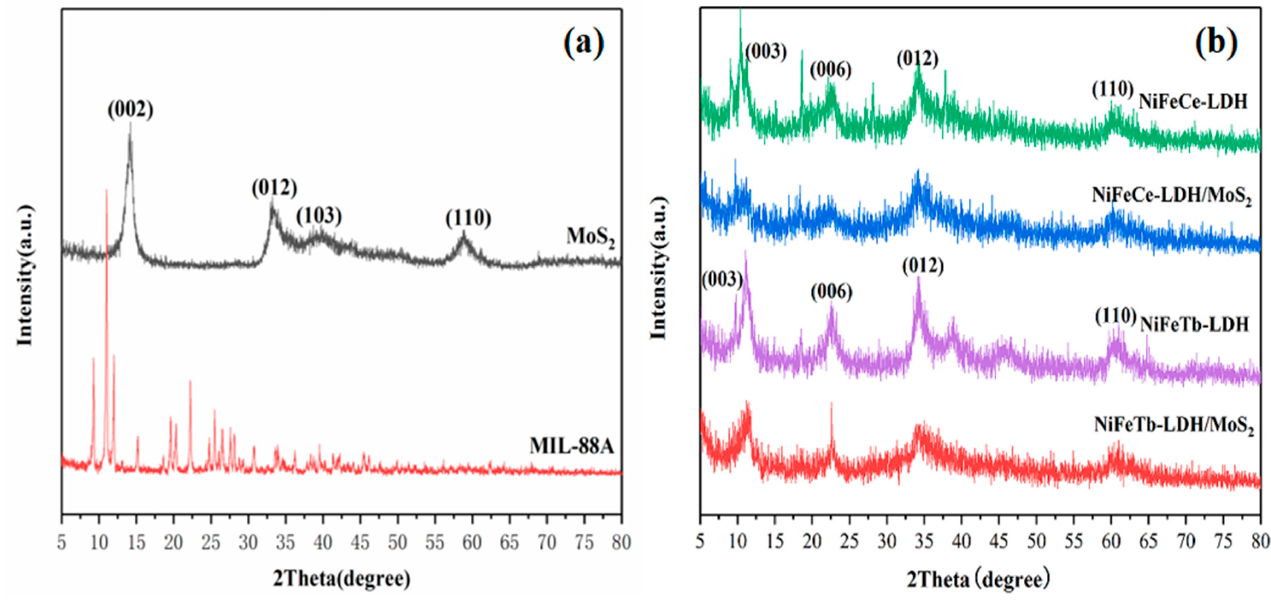
Figure 2. XRD patterns of MIL-88A, MoS 2 ( a ) and NiFeCe-LDH, NiFeTb-LDH, NiFeCe-LDH/MoS 2 , NiFeTb-LDH/MoS 2 ( b ).